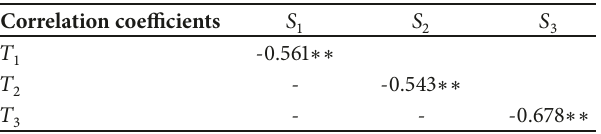
Table 4: Analysis results of the overall evaluation and individual